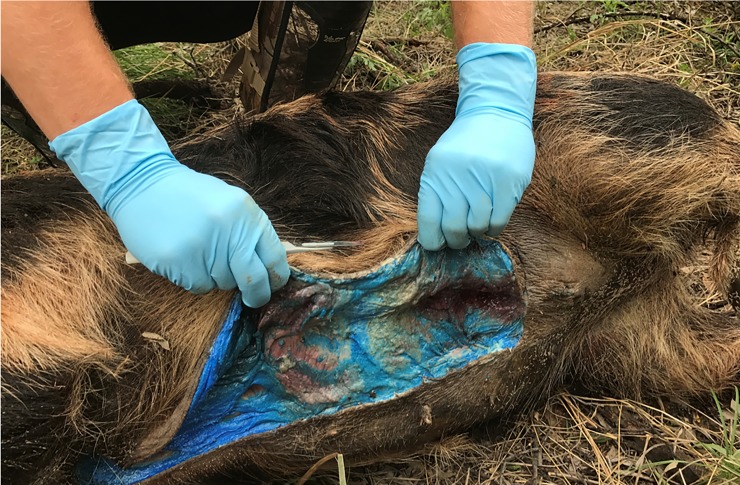
Wild pig succumbing to warfarin as evidenced by the blue subcutaneous fat, resulting from ingestion of the Keystone Blue dye.